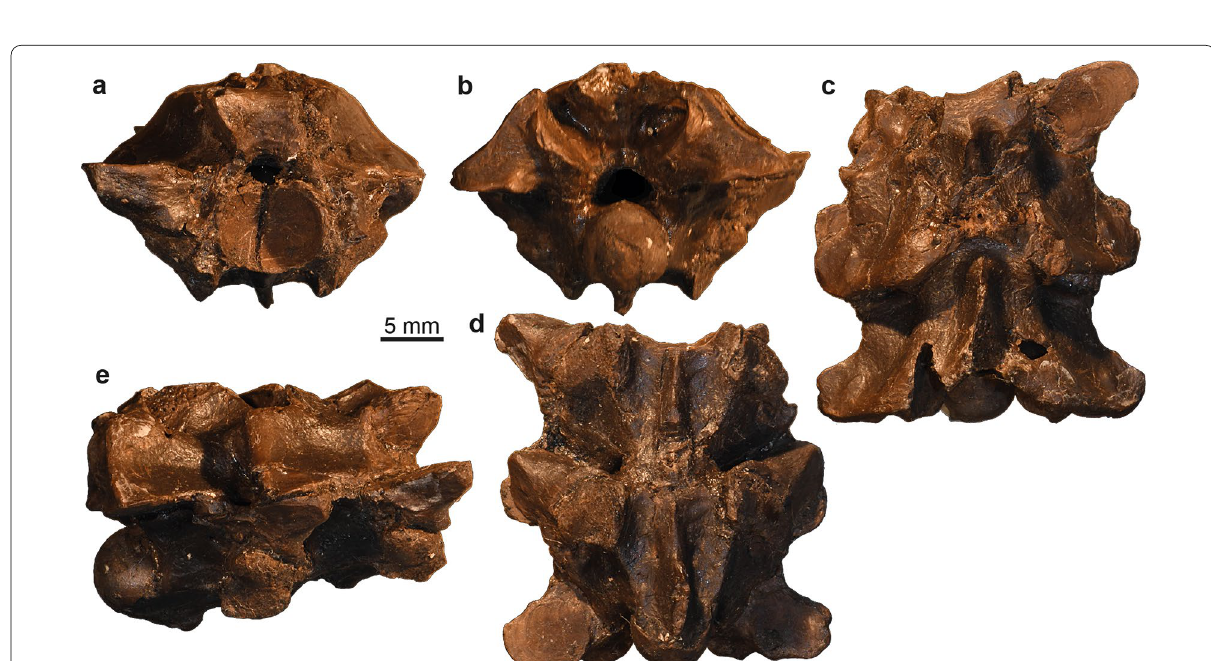
Fig. 23 Palaeopython ceciliensis from quarry XXXV, Geiseltal: two articulated anterior mid-trunk vertebrae (GMH XXXV-485c-1963) in anterior ( a ), posterior ( b ), dorsal ( c ), ventral ( d ), and right lateral ( e )